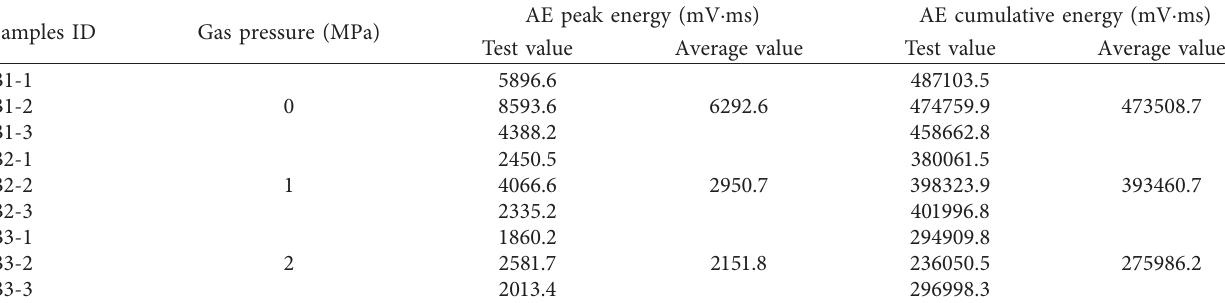
Figure 16: Relationship of AE signals and stress and time about coal samples of different gas pressures under uniaxial compression. (a, b, c, and d) Coal sample without gas: B1-2; (e, f, g, and h) Coal sample with 1 MPa gas pressure: B2-3; (i, j, k, and l) Coal sample with 2MPa gas pressure: B3-2. Table 7: AE signal of coal samples with different gas pressures under uniaxial